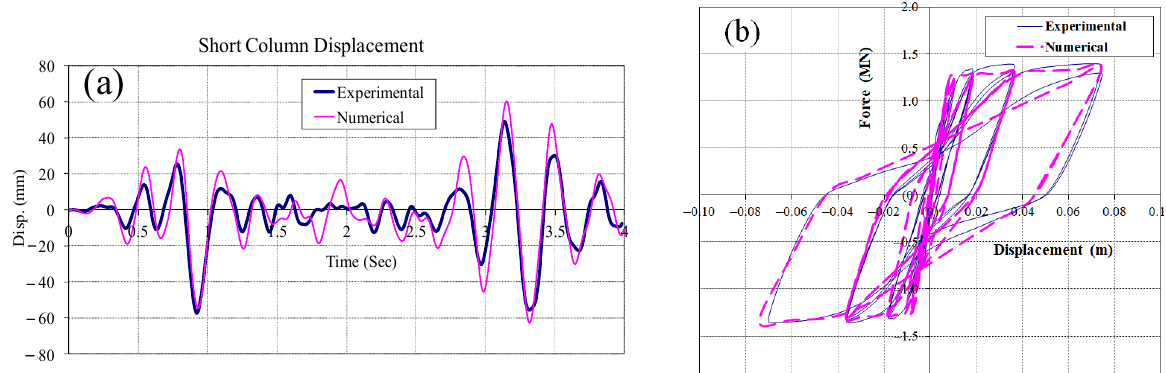
Figure 3. Comparison of the experimental data for the short column of the bridge B213C tested by Pinto et al. [21] and results from numerical analysis: ( a ) column displacement for the maximum earthquake; and ( b ) response of the column in reversed cyclic loading test.